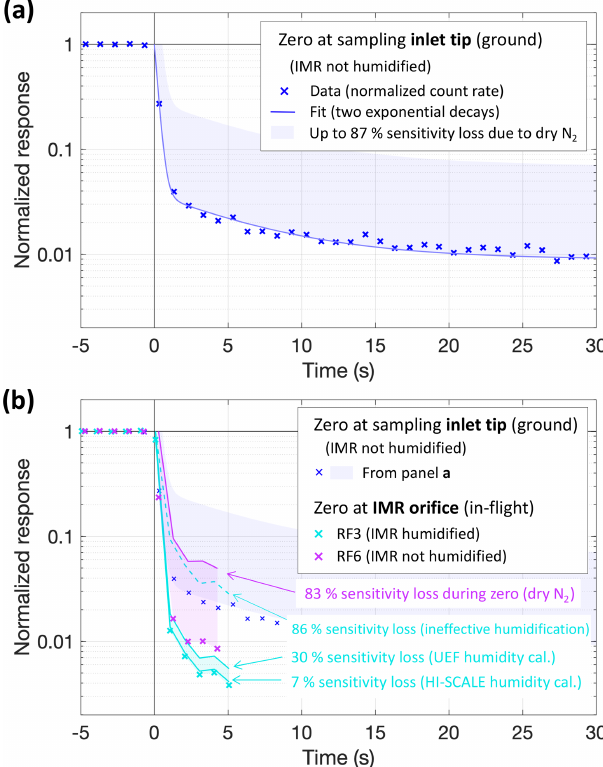
to 6 ]). 6 Figure 3. Responses to instrument zeros by overflowing dry N 2 . Blue: a zero at the sampling inlet tip performed on the ground (pre- flight, RF16, 19 May, ambient [NH 3 ] = 2.9ppb); crosses are nor- malized count rates; the line (panel a only) presents a fit of these data by the sum of two exponential decays with time constants of 0.24 and 6.4s; the shaded area is for multiplying the fit by up to a factor of 7.7 (except for unity as the upper bound) corresponding to the loss of sensitivity observed in dry N 2 vs. ambient air (Figs. S2c and 2). Panel (b) compares these results to examples for in-flight ze- ros at the IMR orifice (magenta and cyan), randomly chosen among momentarily stable [NH 3 ] signals during RF6 (17:24UTC, 3 May, ambient [NH 3 ] = 3.9ppb) and RF3 (21:44UTC, 28 April, ambient [NH 3 ] = 2.5ppb). Crosses are again normalized count rates; lines and shadings indicate underestimations of zero signals due to dry- ing by the N 2 overflowing the IMR orifice following Fig. 2. Unlike most flights, the IMR was continuously humidified via a separate line during RF3 (cyan); the dashed line indicates the underestima- tion in case the IMR humidification was entirely ineffective in main- taining sensitivity to NH 3